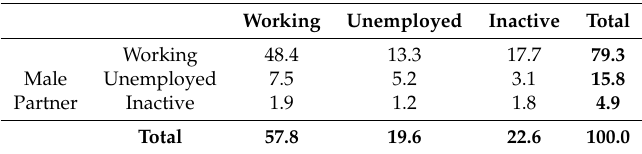
Table 3. Employment status and health status of individuals from co-residing couples aged 30–59. Spain 2012. Percentages.